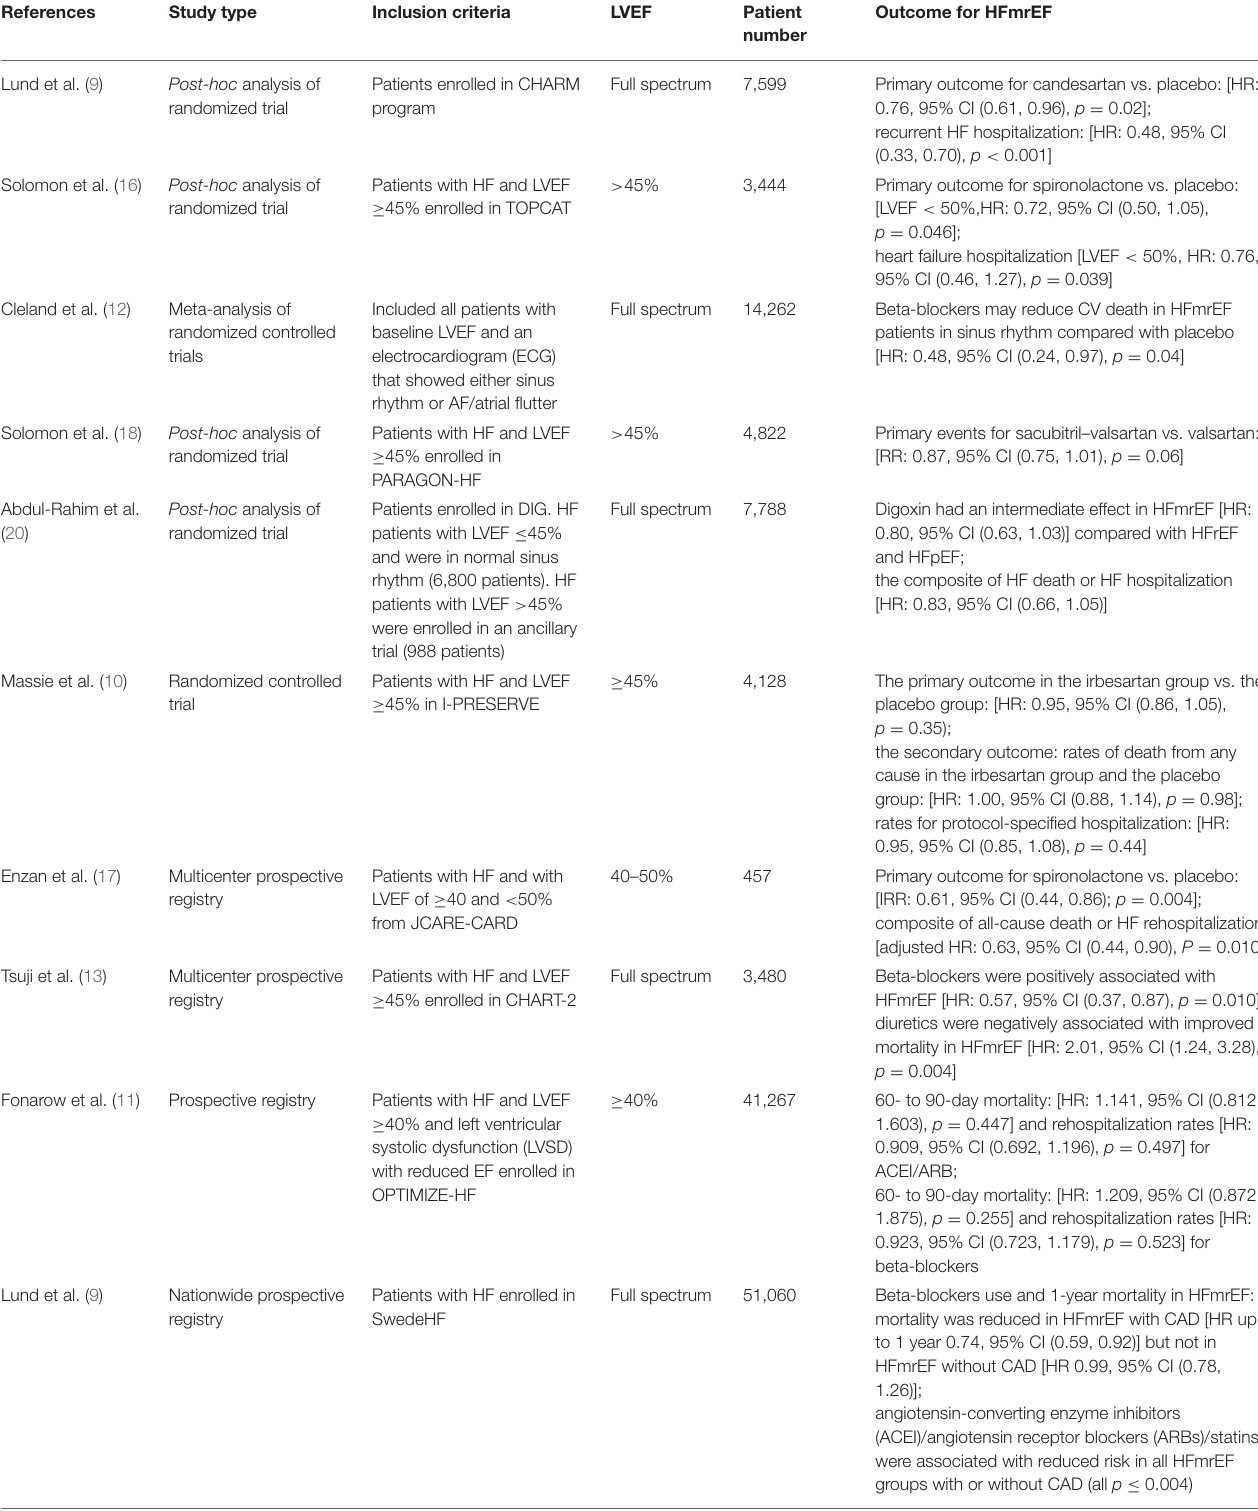
TABLE 1 | Overview of the main studies investigating patients with HFmrEF.